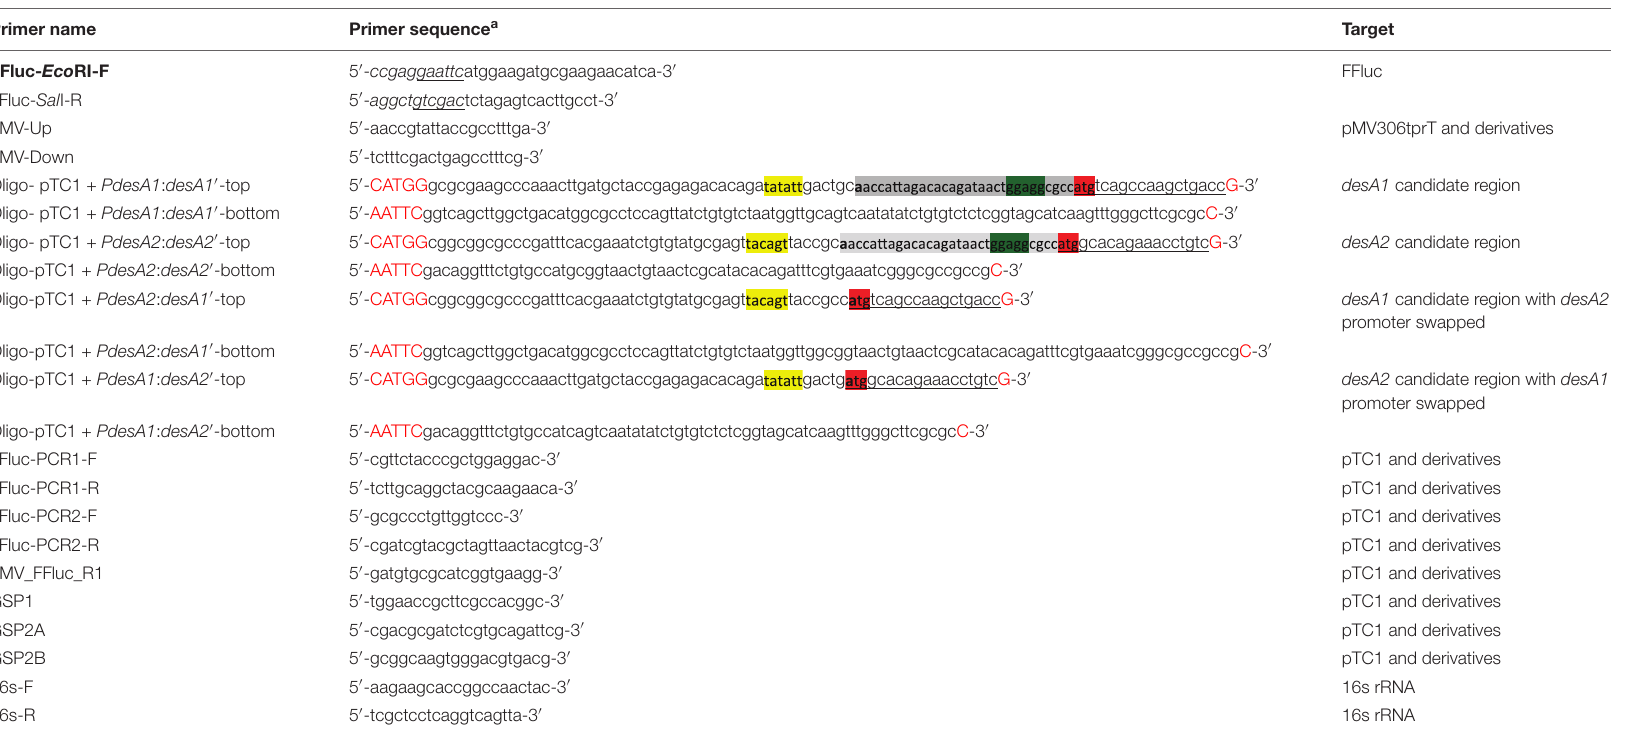
TABLE 1 | Primers used in this